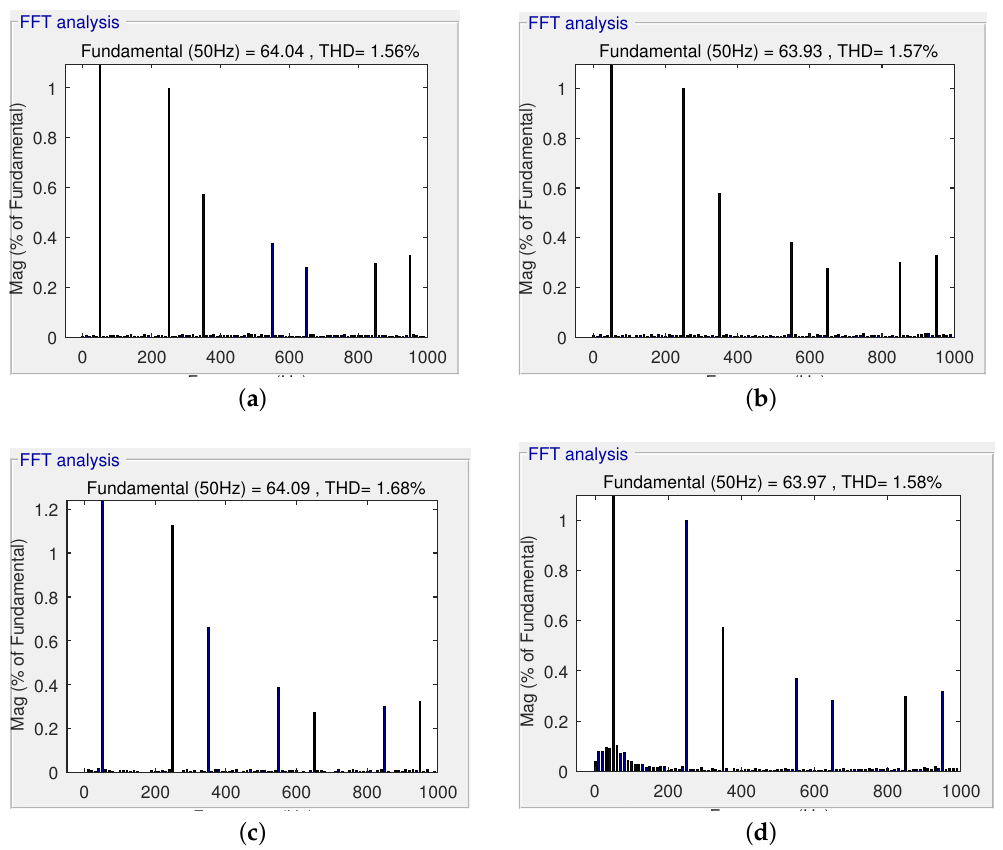
Figure 15. THD comparison between conventional PI controller and fuzzy adaptive PI controller. ( a ) Conventional PI controller with k p = 2.5, k i = 5, ( b ) conventional PI controller with k p = 2.5, k i = 50, ( c ) conventional PI controller with k p = 10, k i = 50, and ( d ) fuzzy adaptive PI